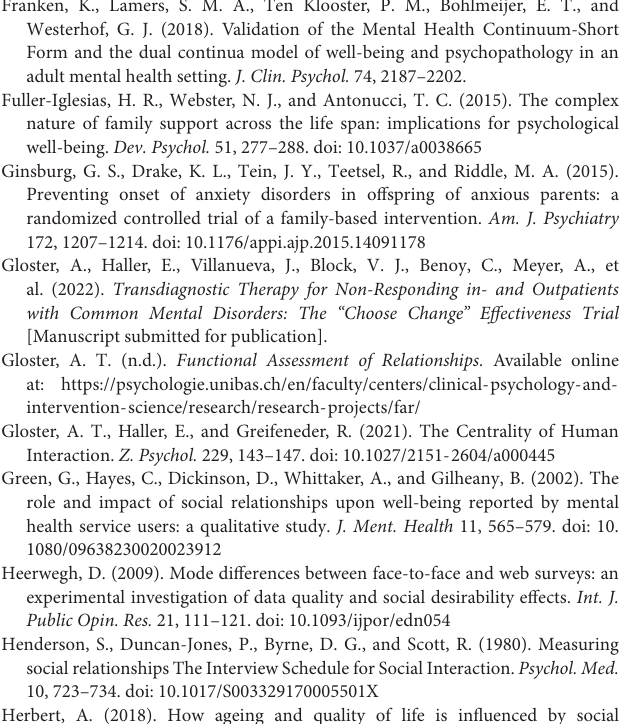
Supplementary Figure C | Visualization of the association of the relationship function ratings and wellbeing for both the community and the patient group.